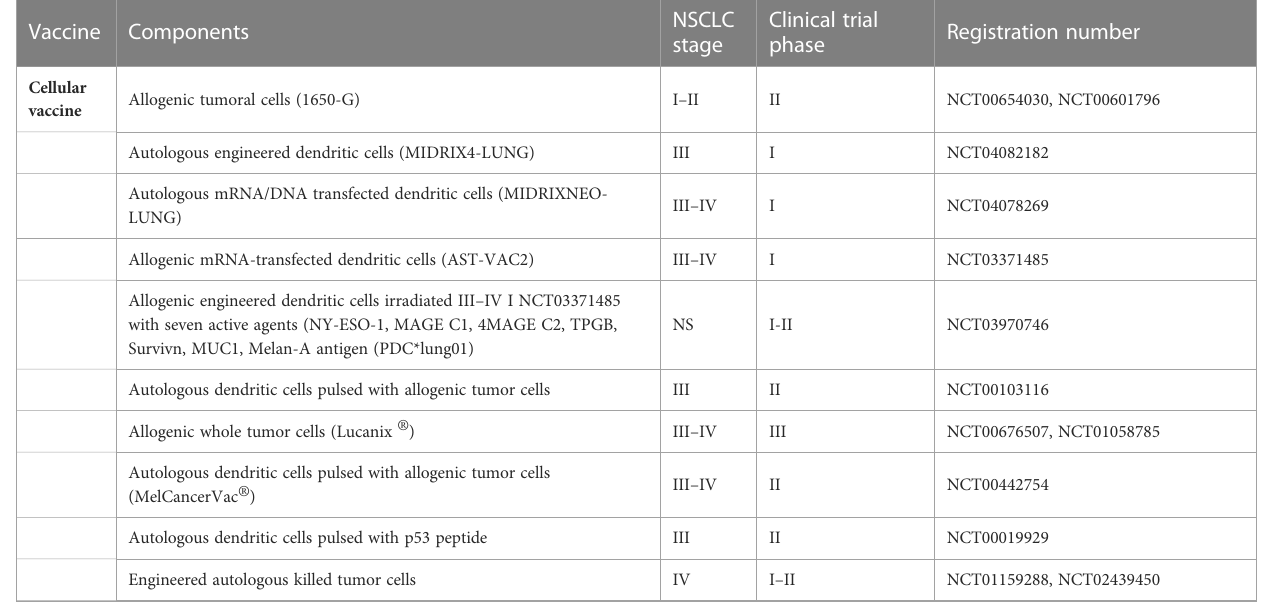
TABLE 3 Currently available clinical trials evaluating cancer vaccines for NSCLC.